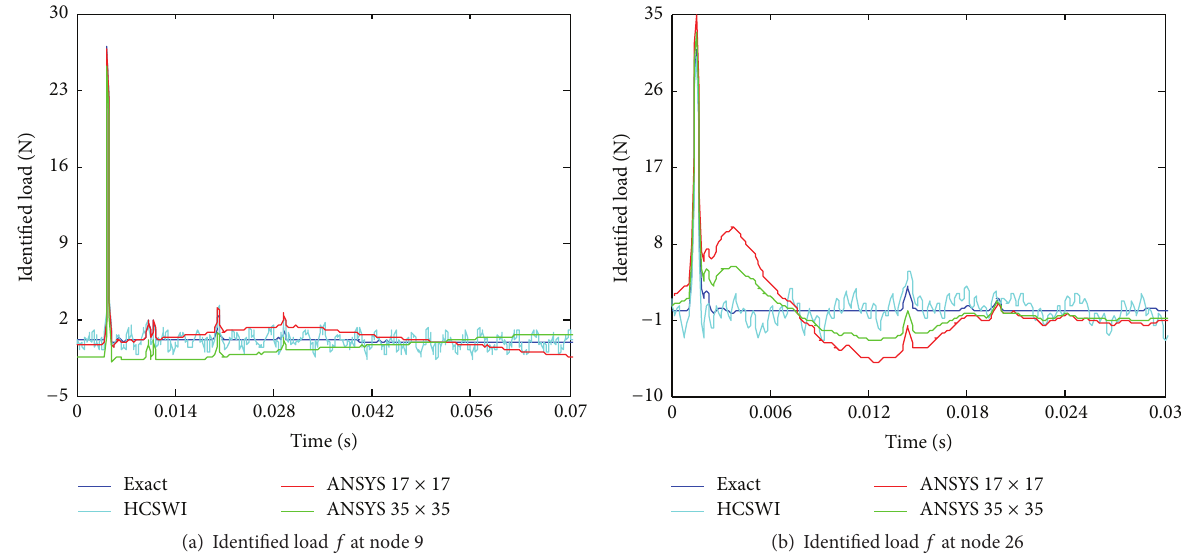
Figure 23: Load identification at node 8 with excitation 𝑓 applied at nodes 9 and 26.